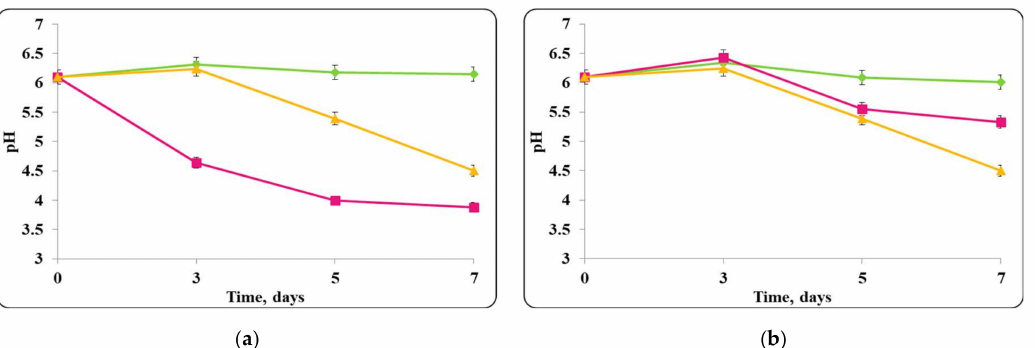
Figure 7. ( a ) free lactobacilli cells; ( b ) encapsulated lactobacilli cells. Changes in the total titratable acidity (TA) of MRS broth inoculated with Lb. helveticus 2/20 and E. coli ATCC 25922 during storage at 4 ± 2 ◦ C. Legend: Green (cid:117) : TA of MRS broth inoculated with Lb. helveticus 2/20; Pink (cid:4) : TA of MRS broth co-inoculated with Lb. helveticus 2/20 and E. coli ATCC 25922; Yellow (cid:78) : TA of MRS broth inoculated with E. coli ATCC 25922.